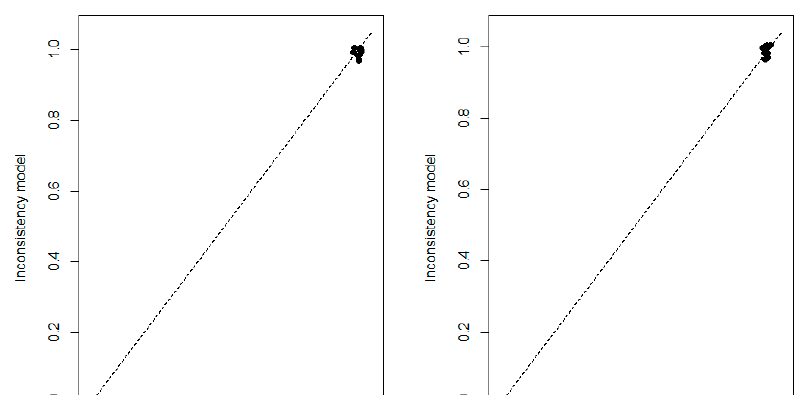
Scheme A2. Deviance plot.